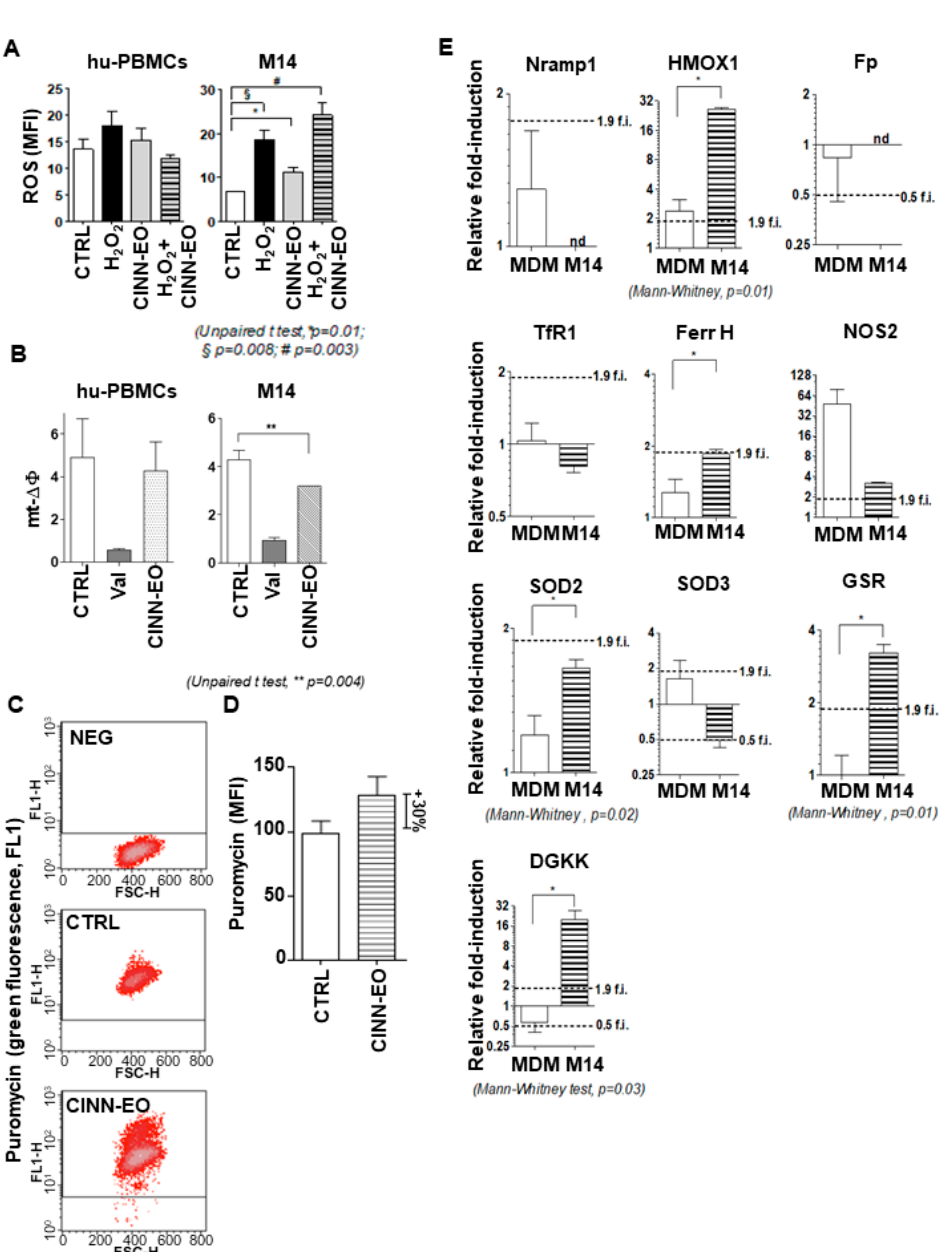
Figure 4. CINN-EO a ff ects intracellular oxidative and iron metabolism. ( A ) ROS production in M14 cells and hu-PBMCs. ( B ) Mitochondrial membrane potential (mt- ΔΦ ) in M14 cells and hu-PBMCs. ( C ) Representative cytograms of puromycin induction after CINN-EO treatment in M14 cells. CTRL, untreated cells; CINN-EO, treated cells. ( D ) Puromycin mean fluorescence intensity (MFI), as evaluated by FACS and normalised to the cell protein content, indicating the intracellular iron(II) amount after CINN-EO treatment. The results are the average of three independent experiments. ( E ) Gene expression in MDMs and M14 cells upon CINN-EO treatment (* p < 0.05; nd, not detected). Relative fold-induction were calculated versus control